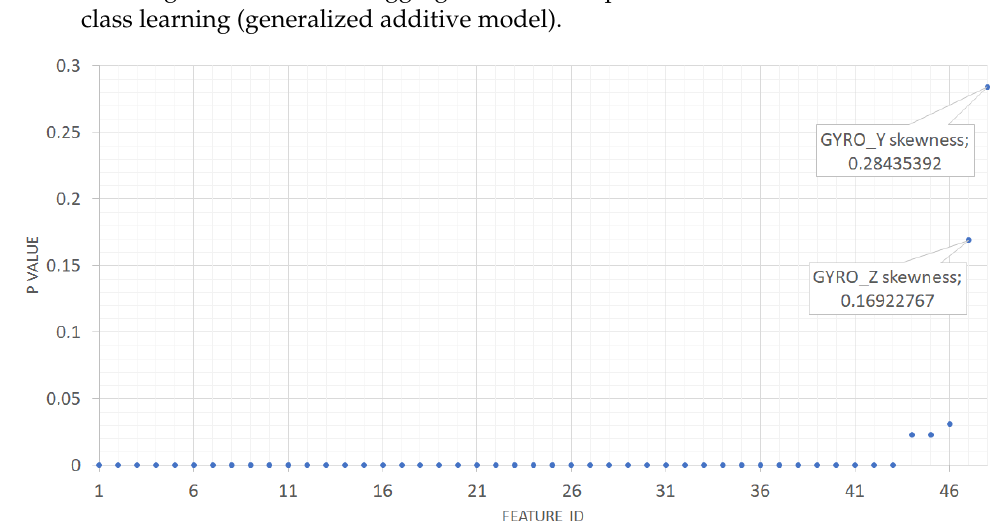
Figure 3. The p -Values associated to the ANOVA test for each feature. The features are ranked in order of decreasing F-score. It can be noted that with the exception of two features, all p -values were below 0.05, meaning that their associated F-scores were significant.